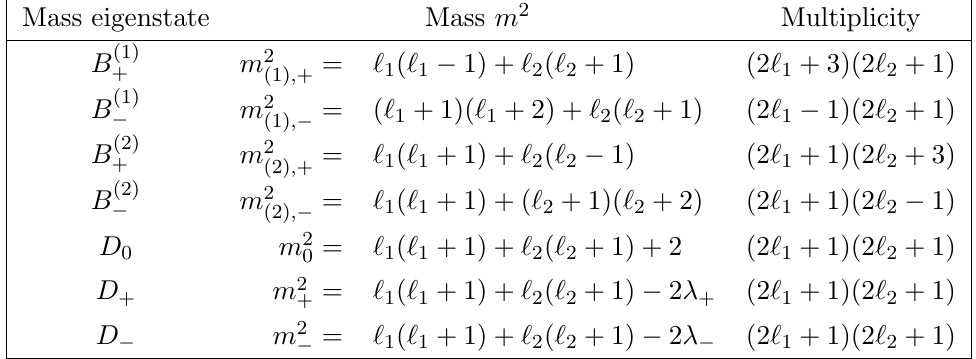
Table 3 . Masses and eigenstates of the complicated bosons in the k 1 k 2 (cid:2) k 1 k 2 block in the SO(3) (cid:2) SO(3)-symmetric case. One must consider all combinations of ‘ 1 = 1 ; : : : ; k 1 (cid:0) 1 and ‘ 2 = 1 ; : : : ; k 2 (cid:0) 1. The masses for the (cid:12)elds in the o(cid:11)-diagonal blocks are obtained by